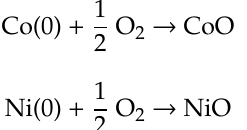
Figure 14. XRD patterns of Co 2 Ni 2 Mg 2 Al 2 800 after test in the presence of toluene (* C cubic JCPDS N° 800017; + C hexagonal JCPDS N ◦ 751621; # Co 2 AlO 4 JCPDS N ◦ 380814 / CoAl 2 O 4 JCPDS N ◦ 440160 / Co 3 O 4 800017; + C hexagonal JCPDS N° 751621; # Co 2 AlO 4 JCPDS N°380814 / CoAl 2 O 4 JCPDS N°440160 / JCPDS N ◦ 421467; × Co JCPDS N ◦ 150806 / Ni JCPDS N ◦ 211152; ◦ MgO JCPDS N ◦